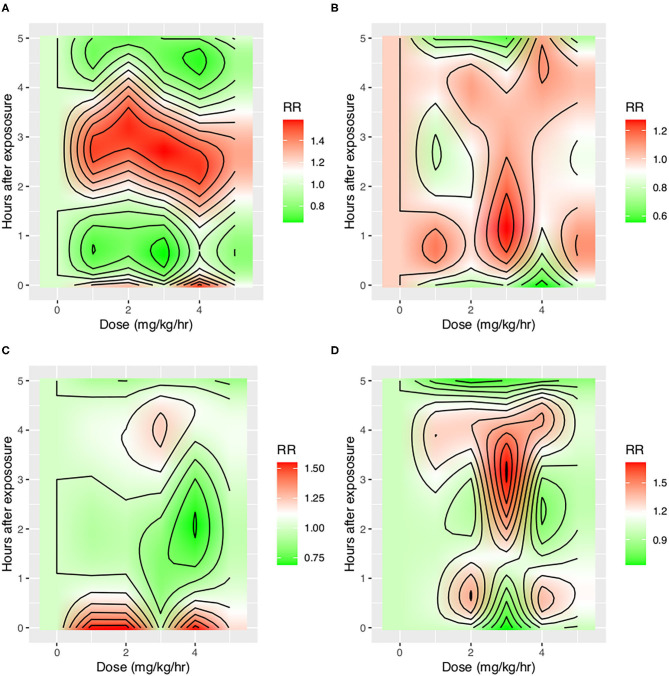
Impact of propofol on four types of asynchrony. Propofol was entered into the distributed lag non-linear model with two dimensions: dose and time lag. The y-axis shows the time after instantaneous exposure of propofol, so the drug was assumed to be discontinued after a certain dose exposure. Other covariates including tidal volume, WOB, PEEP, plateau pressure, mode of ventilation, and day hours were adjusted. The red color shows increased risk of asynchrony, and the green color shows reduced risk of asynchrony. (A) Impact on DT, (B) Impact on IEE, (C) Impact on PC, and (D) Impact on SC. IEE, ineffective effort; DT, double triggering; SC, short cycling; PC, prolonged cycling.